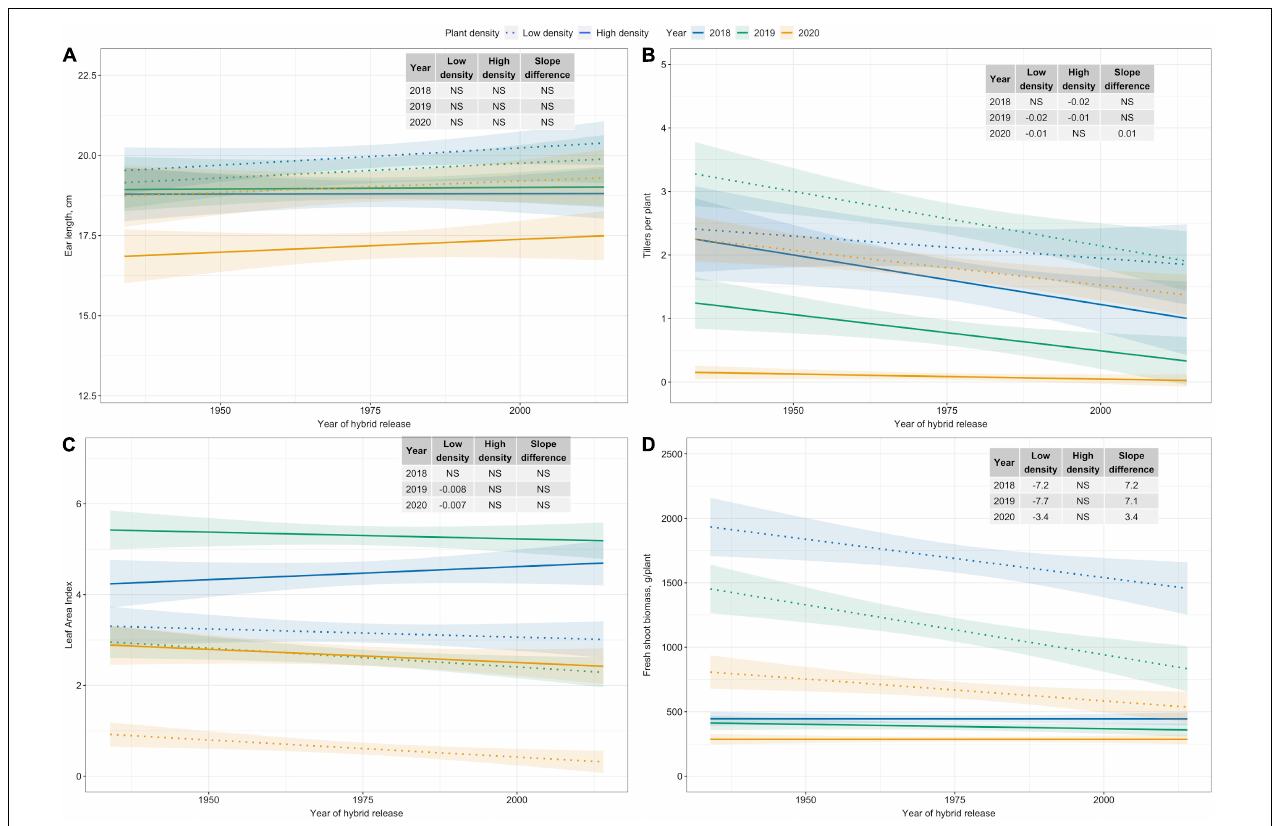
FIGURE 4 | Best fit line for relationship between year of hybrid release and (A) ear length (cm), and (B) tillers per plant, (C) leaf area index, and (D) fresh shoot biomass (g/plant) for two levels of plant density at Urbana, IL in 2018–2020. Ninety-five percent confidence intervals are shown by the shaded regions around the line of best fit. Slope estimates from linear regression analysis for Low plant density (9,900 plants/ha), High plant density (79,000 plants/ha), and difference between two plant densities are shown. Non-significant slope estimates are denoted by NS ( α = 0 .